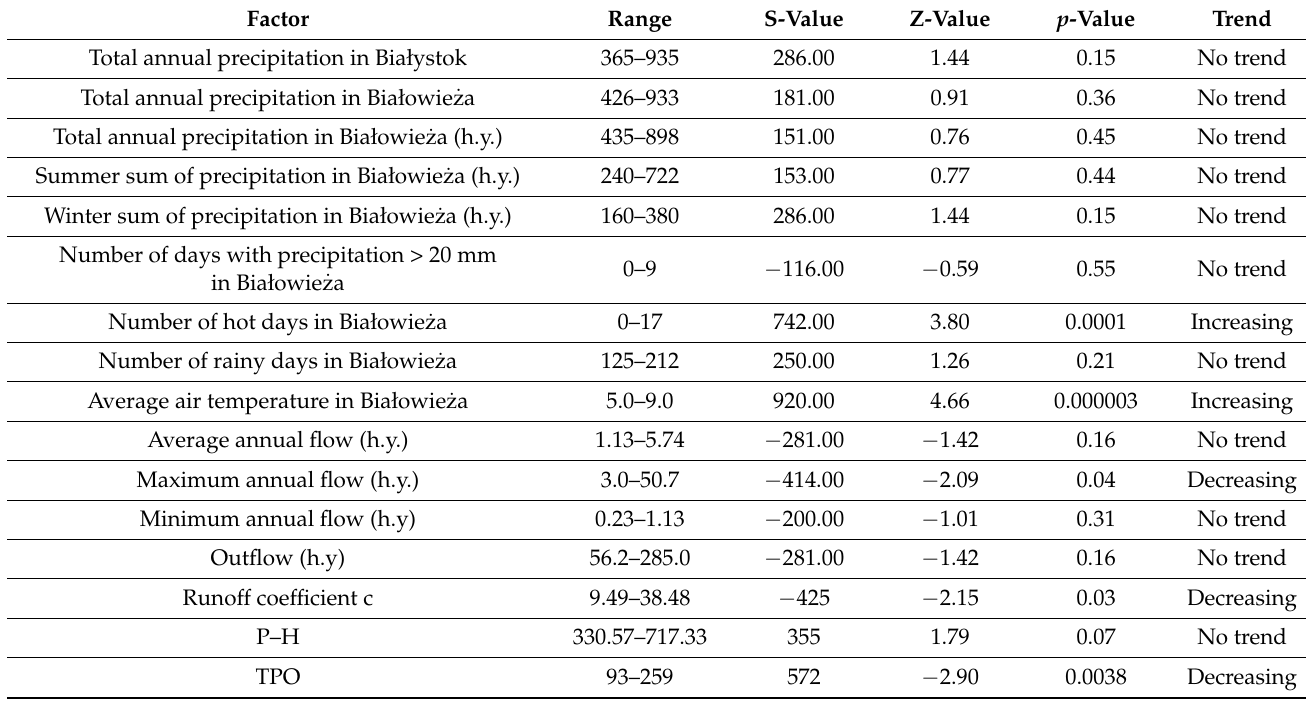
Figure 6. Annual precipitation at the Bia ł owie ż a climatic station, with information on the precipitation classification of years according to the RPI criterion.